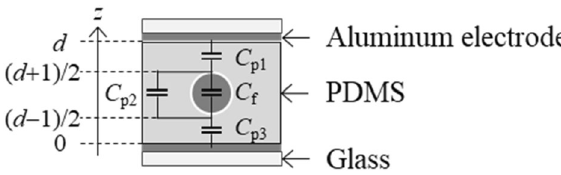
Figure 6. Schematic cross section of the channel and the equivalent